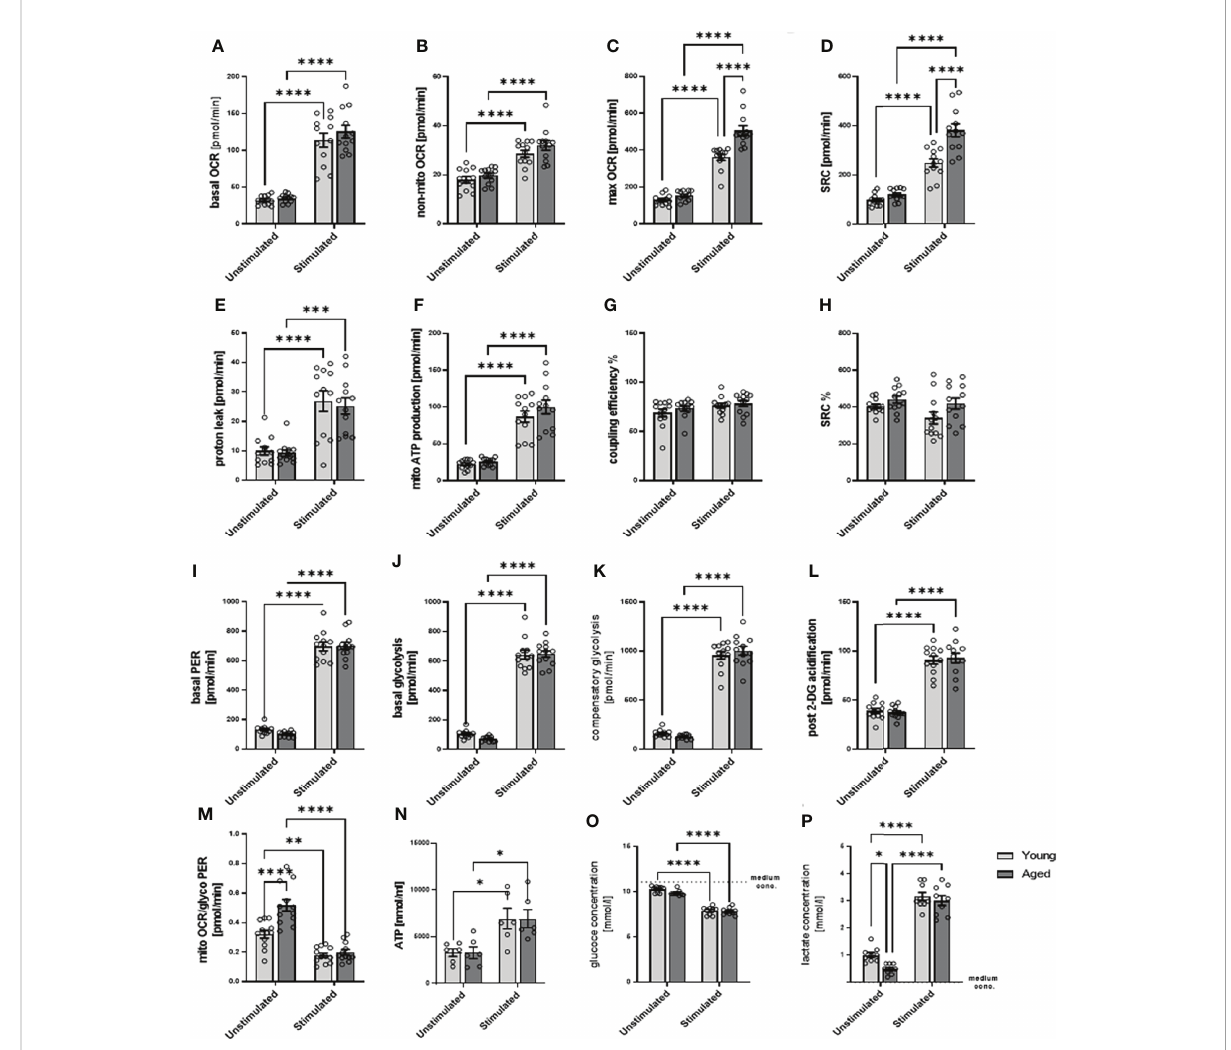
FIGURE 3 Mitochondrial pro fi le, glycolytic pro fi le, steady-state ATP level, glucose consumption, and lactate secretion of stimulated/unstimulated memory CD4 + T cells in young and aged male donors. Comparison of basal OCR (A) , non-mito respiration (B) , maximal respiration (C) , spare respiratory capacity (D) , proton leak (E) , ATP production (F) , coupling ef fi ciency (G) , and spare respiratory capacity% (H) in stimulated/unstimulated memory CD4+ T cells from young and aged donors. Comparison of basal PER (I) , basal glycolysis (J) , compensatory glycolysis (K) , post-2-DG acidi fi cation rate (L) , and basal mitoOCR/glycoPER ratio (M) in stimulated/unstimulated memory CD4 + T cells from young and aged donors (mean ± SEM; n = 12). (N) Steady-state ATP content of stimulated/unstimulated memory CD4 + T cells from young and aged donors after 24 h was measured by bioluminescence (mean ± SEM; n = 6). (O) Comparison of the reduction in medium glucose concentration as a measure of glucose consumption and (P) the increase in medium lactate concentration as a measure of glycolytic lactate production in stimulated/ unstimulated memory CD4 + T cells from young and aged donors (mean ± SEM; n=9). (A – P) Multiple comparisons were analyzed by two-way ANOVA with the Bonferroni multiple-comparison post hoc test. *P<0.05, **P<0.01; ***P<0.001, ****P<0.0001. OCR, oxygen consumption rate; PER, proton ef fl ux